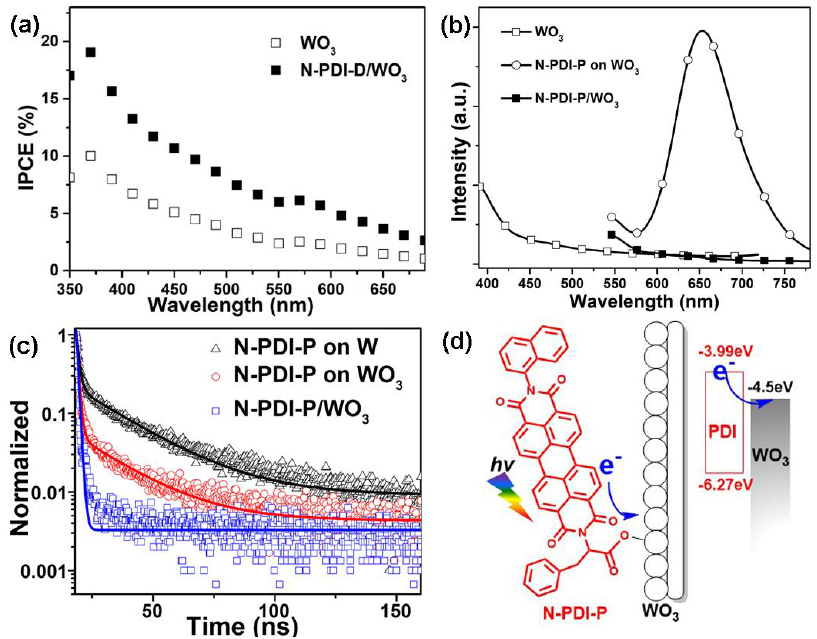
Figure 4. ( a ) IPCE of WO 3 and N-PDI-P/WO 3 composite; ( b ) steady-state photoluminescence of WO 3 , WO 3 with physical adsorption of N-PDI-P film and N-PDI-P/WO 3 Heterojunction; ( c ) TRPL of W, WO 3 with physical adsorption of N-PDI-P film and N-PDI-P/WO 3 composite; ( d ) schematic of charge transfer at the N-PDI-P/WO 3 interface.